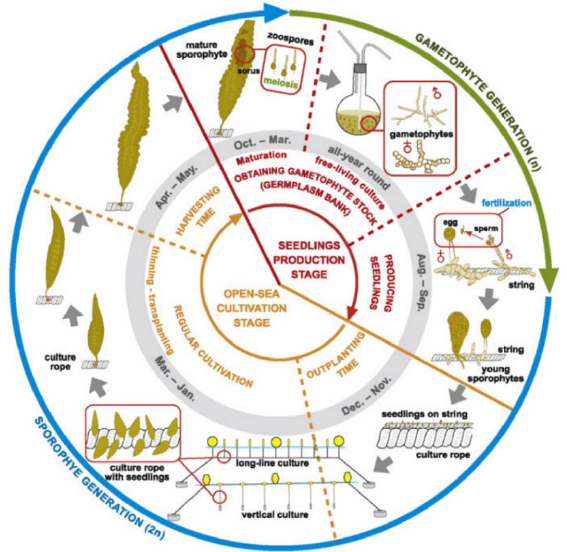
Figure 2. Typical cultivation lifecycle in the northern hemisphere of Saccharina latissimi using seeded strings. Reproduced with Permission [22].